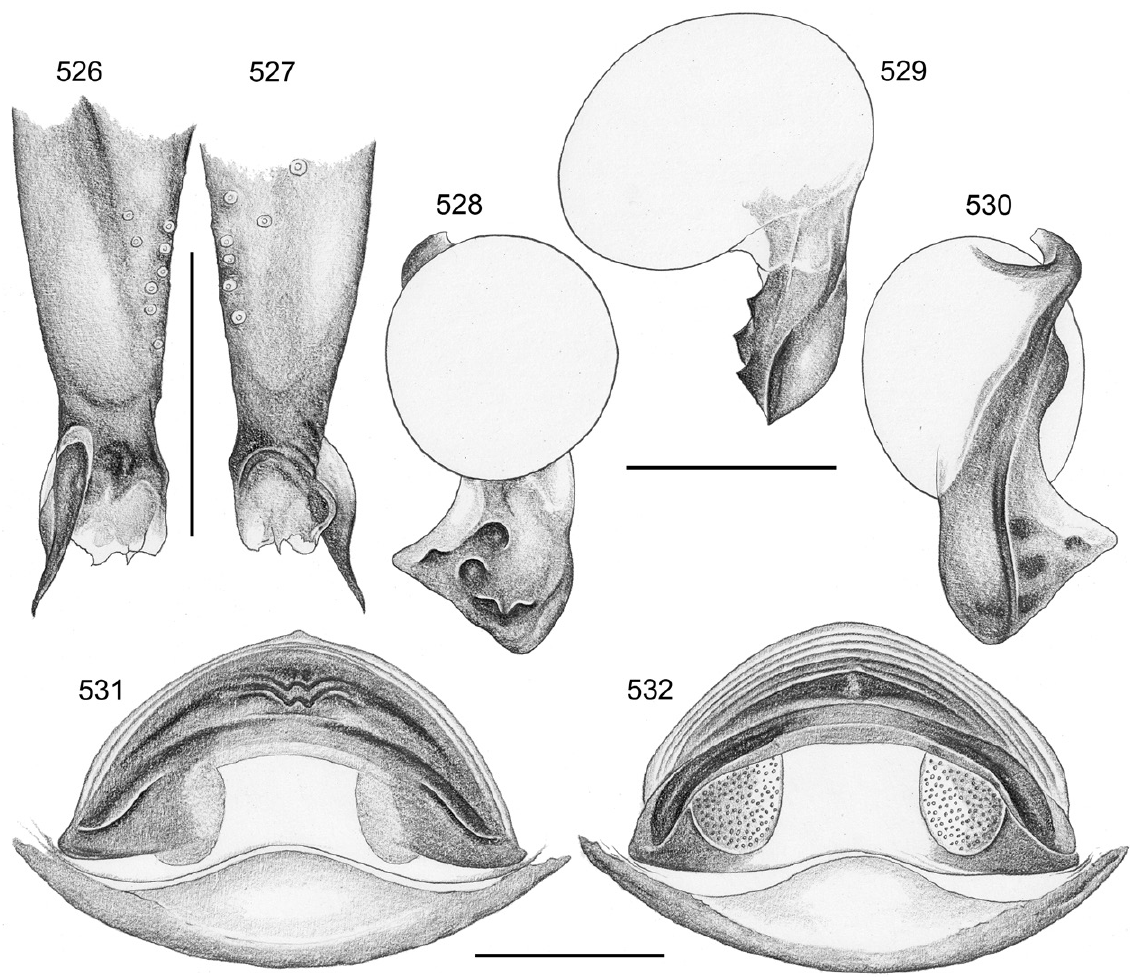
Figs 526–532. Crossopriza ghul sp. nov.; holotype male (ZFMK Ar 22427) and female from Oman, Wadi Ghul (ZFMK Ar 22428). 526–527 . Left procursus, prolateral and retrolateral views. 528–530 . Left genital bulb, prolateral, dorsal, and retrolateral views. 531–532 . Cleared female genitalia, ventral and dorsal views. Scale bars = 0.2